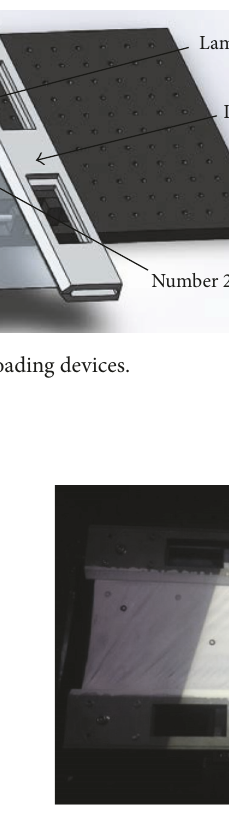
Figure 5: Wrinkling of the clamped